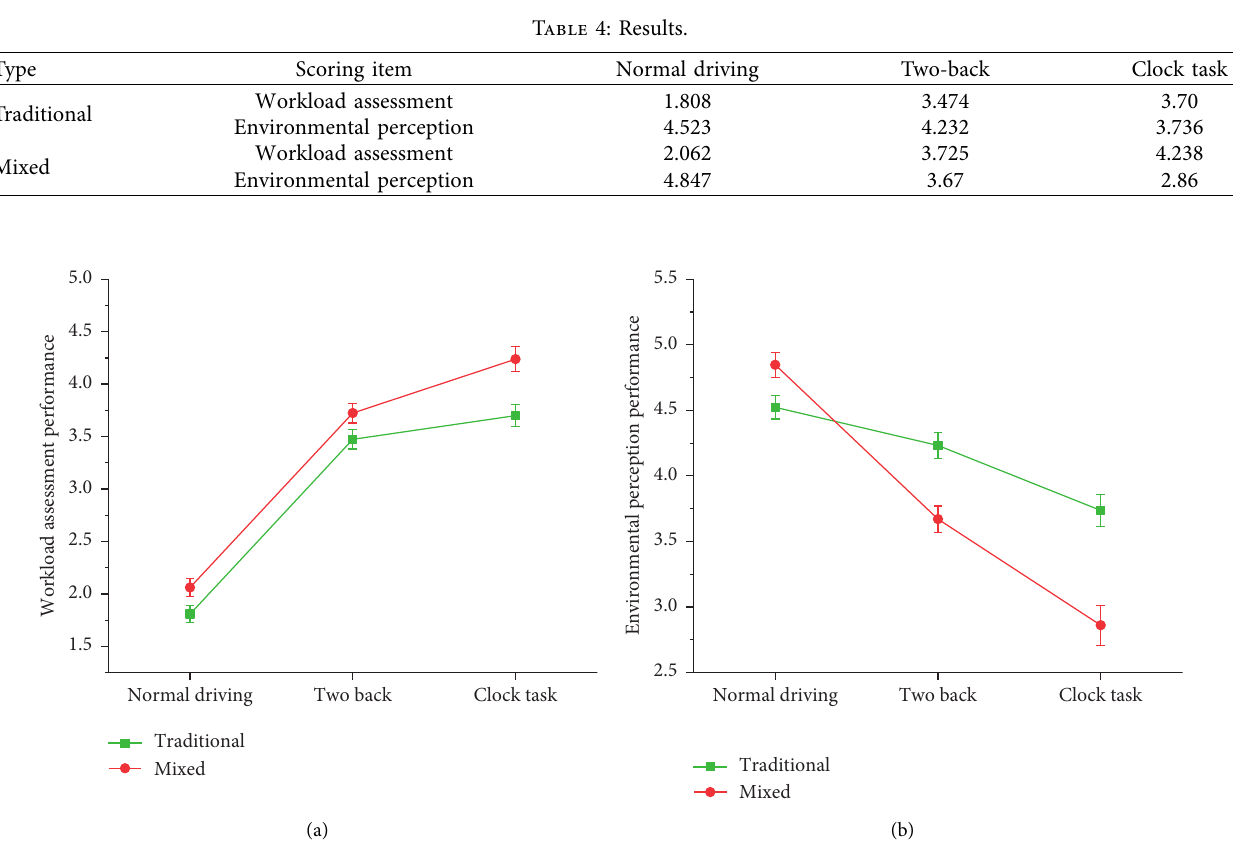
Figure 19: Interaction effect of the driving tasks and environment on the (a) workload assessment performance and (b) environmental perception performance.